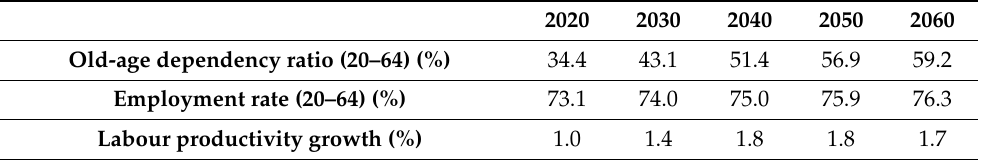
Table 1. The three drivers of the AWG projection by decade, EU averages.